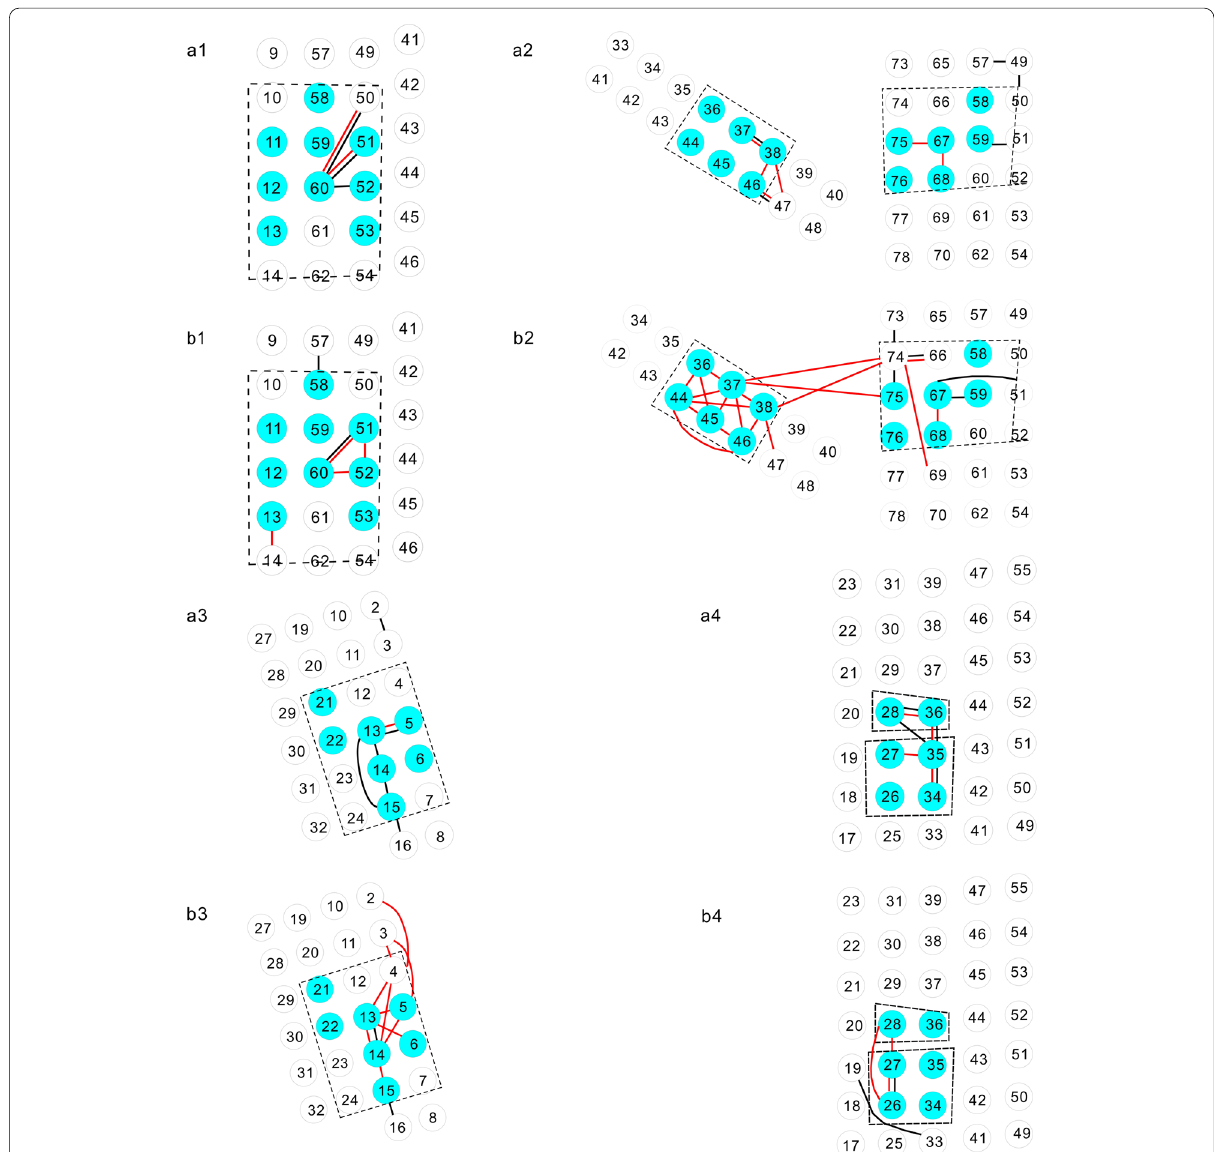
Fig. 6 Diagrams showing electrodes with enhanced synchronization ( a Interictal stage, b Ictal stage; number 1–4 represent the patients 1–4. Blue circles indicate electrodes over the onset areas; solid red and black lines indicate enhanced synchronization in the 14–30 Hz and 30–80 Hz bands, respectively. Dashed black lines delineate resected areas during